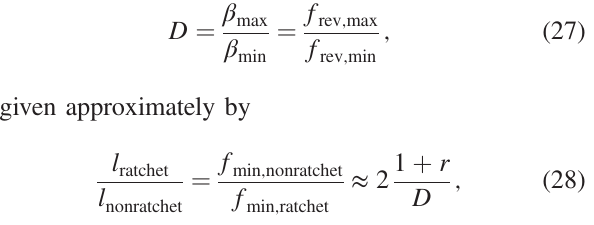
FIG. 4. Active cavity harmonic for the 65 m carbon synchrotron harmonic ratcheting ramp. The cavity begins at h ¼ 9 and ratchets in sequence through h ¼ 7 , 5, 4, 3, 2.